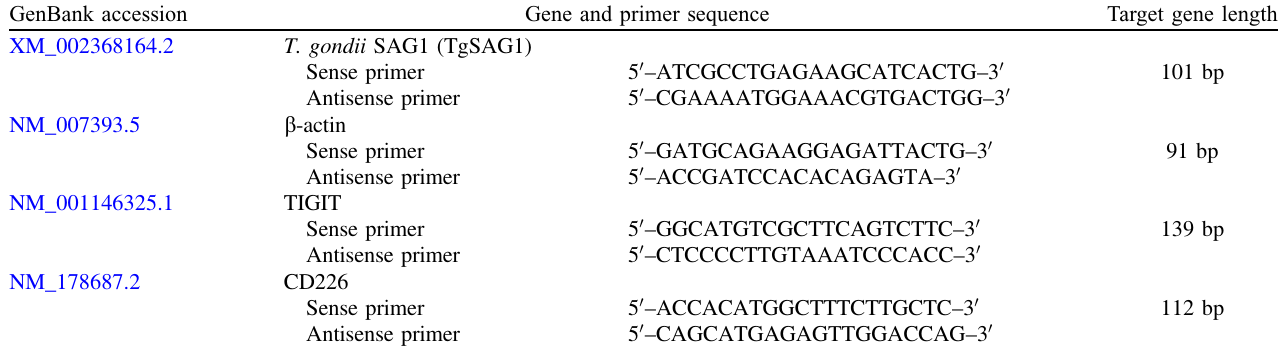
Table 1. Sequences of the primers used in this study. GenBank accession Gene and primer